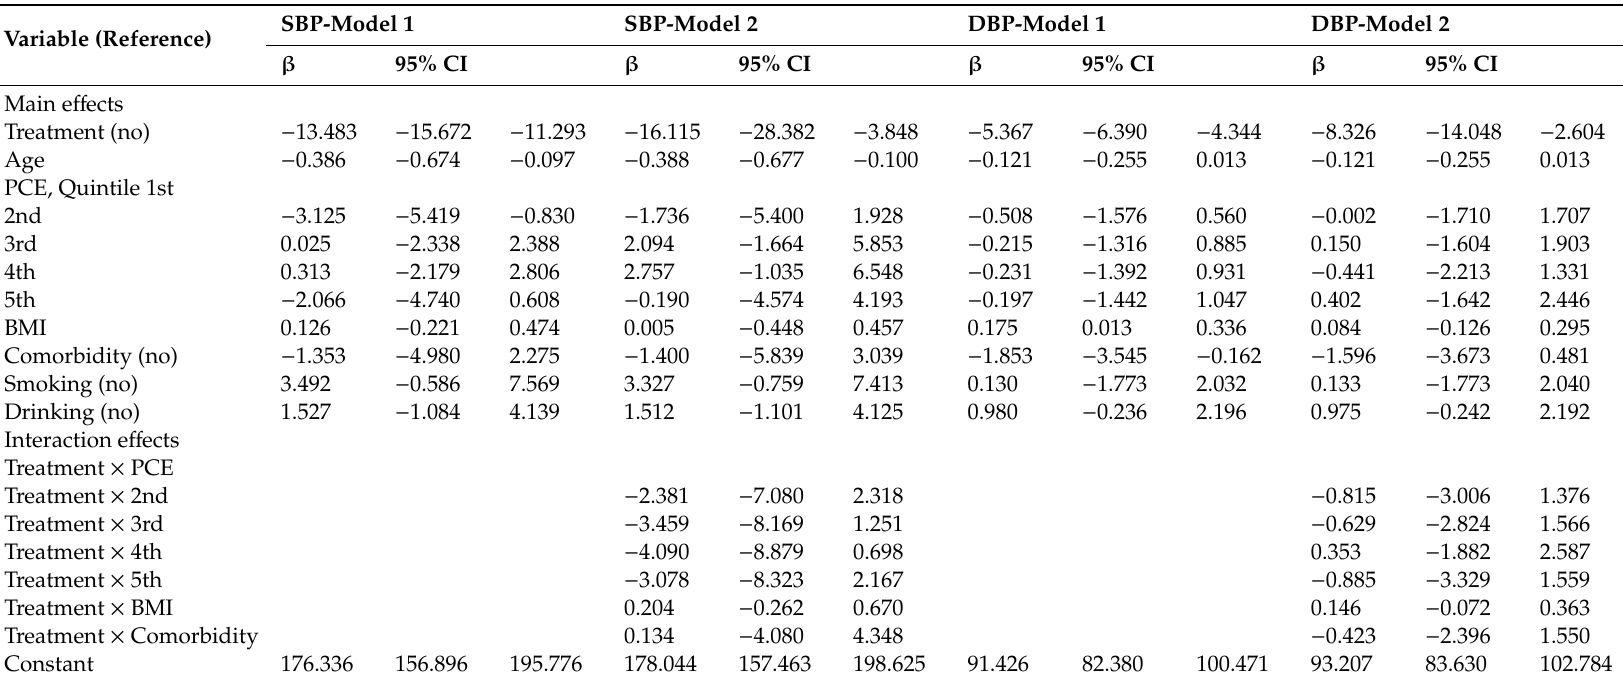
Table 5. Fixed-e ff ects analysis of the relationship between antihypertensive medication treatment and blood pressure